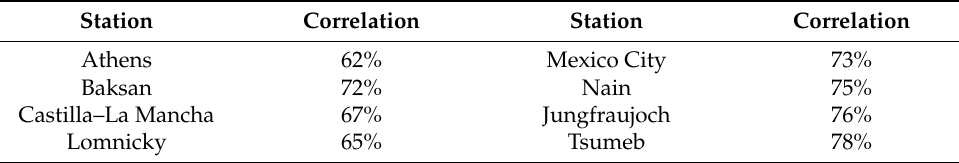
Table 7. Pearson correlation values based on the graphs from Figure